Question: What kind of plot is shown here?
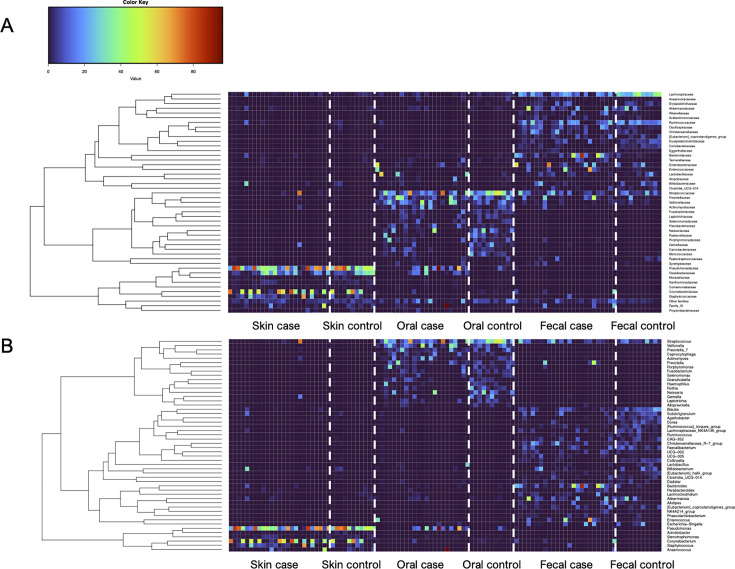
Answer: heatmap